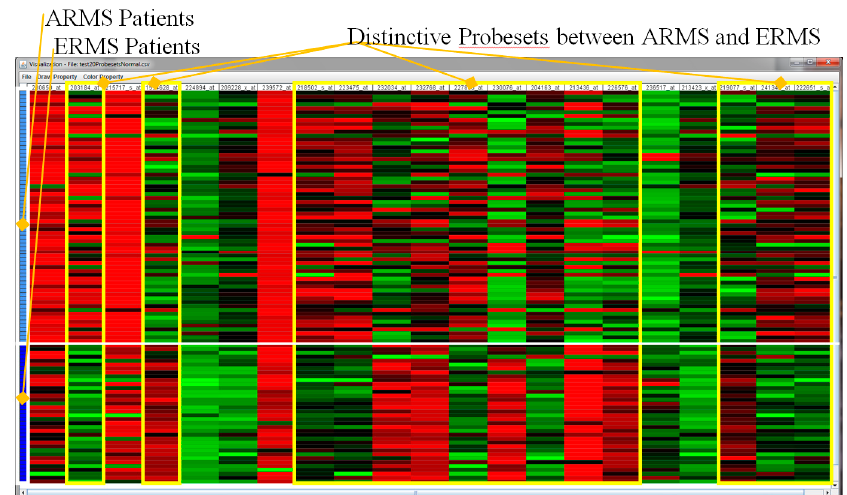
Figure 9. An example of the interactive heat map at the navigational stage, showing the top 20 probe sets selected from the feature selection process. This figure indicates quite clearly the difference of probe sets between two groups of patients ARMS and ERMS, highlighted by yellow rectangles.